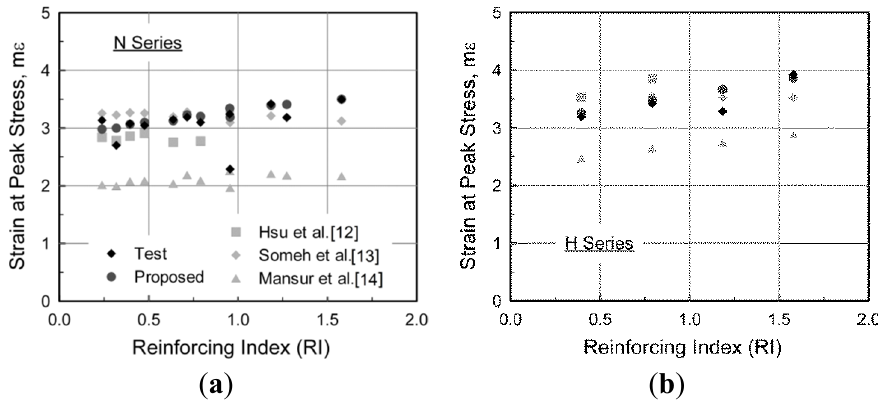
Figure 7. Comparison of the strain at the compressive strength. ( a ) N Series; ( b ) H